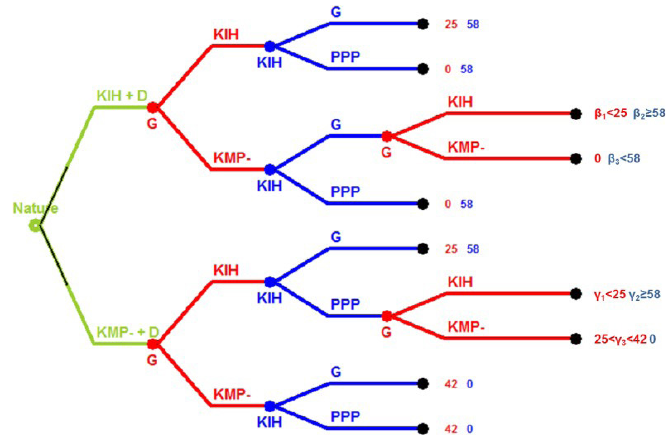
Figure 2: Game Tree of Political Bargaining After Eliminating Dominated Strategies Note: G: Golkar; KIH: Koalisi Indonesia Hebat; KMP-: {Gerindra, P AN, P K S}; D: Demokrat. In order to simplify the presentation, the payoffs are made equal to 100 x Shapley